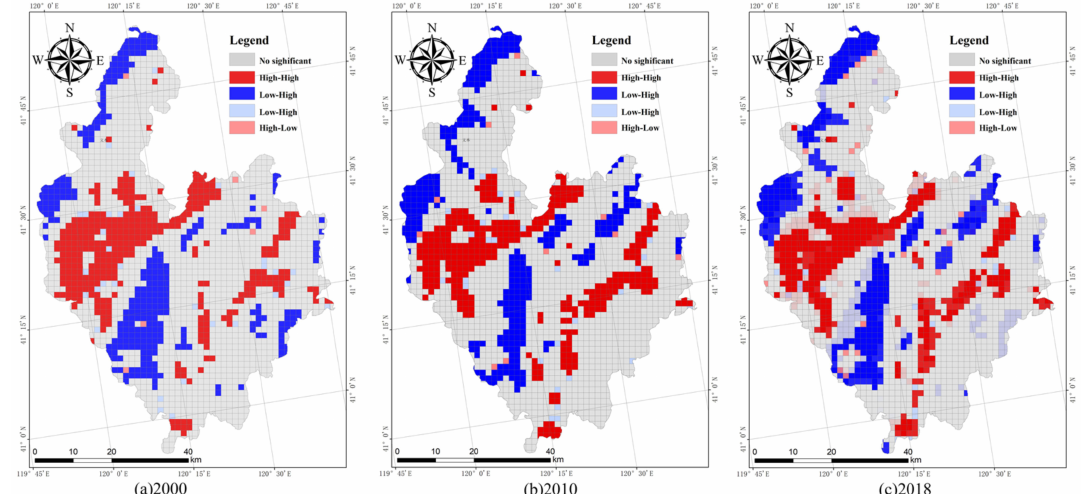
Figure 7. Local autocorrelation index of landscape ecological risk in Chaoyang County in ( a ) 2000, ( b ) 2010, ( c )